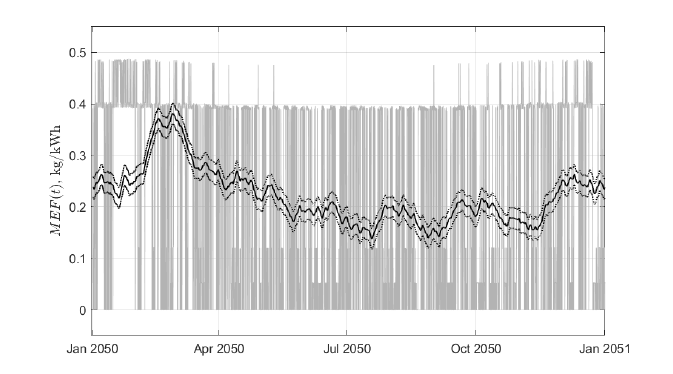
Figure A1. MEF ( t ) across the year in scenario CR50, shown with its moving mean of the previous 30 days, and limits L + and L − which are respectively 0.02 kg/kWh above/below the moving mean.